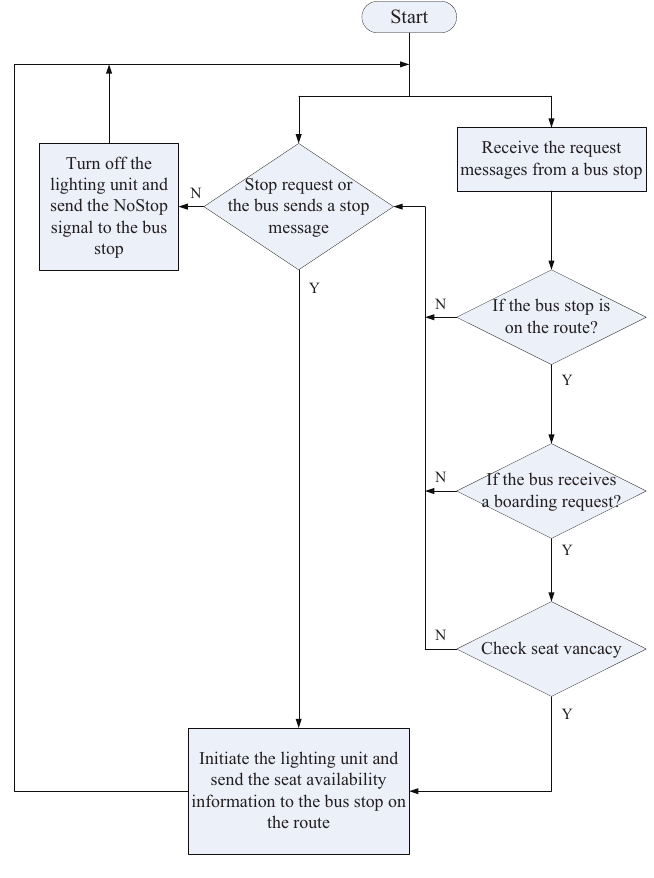
Figure 10. Information flow of a real-time passenger information system: “N” represents “No”; “Y” represents “Yes”.